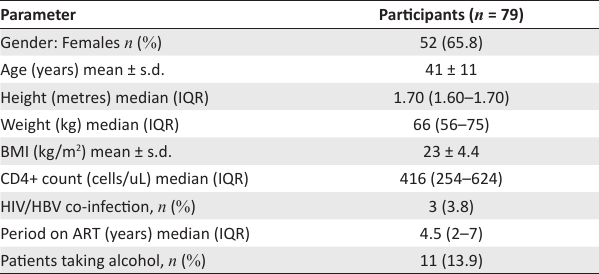
TABLE 2: Demographic characteristics of study participants. Parameter